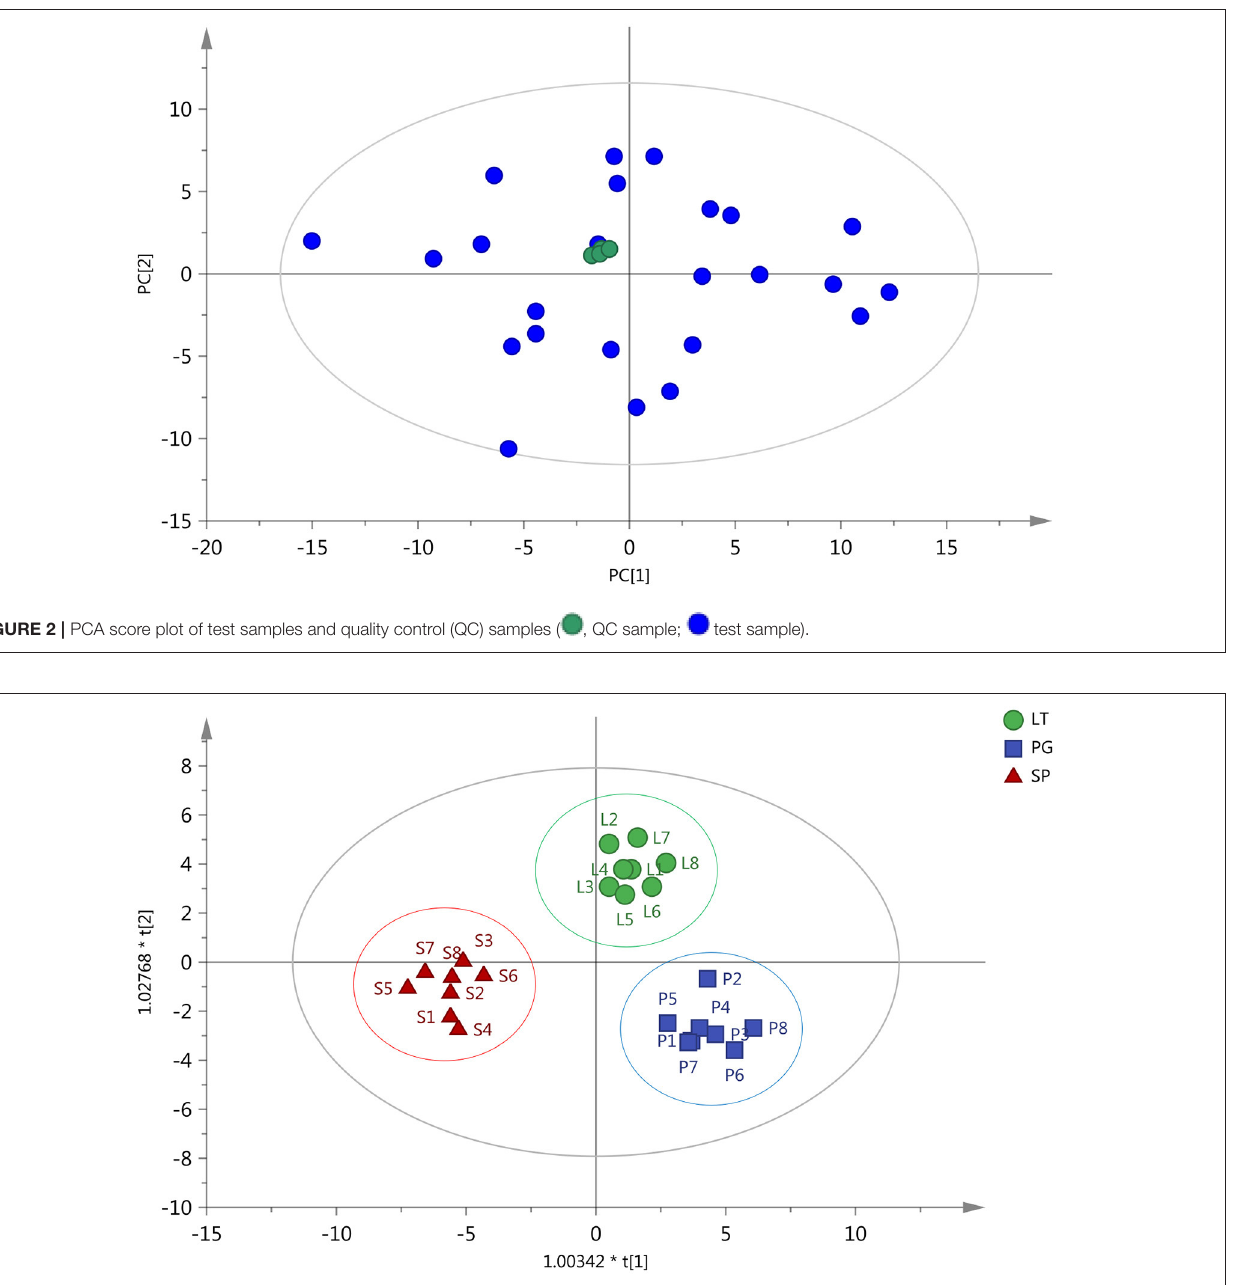
FIGURE 3 | Orthogonal partial least squares-discriminant analysis (OPLS-DA) test for the identification of the three regions of peach samples. PG (Pinggu, Beijing ), SP (Shunping, Hebei ), and LT (Laoting, Hebei